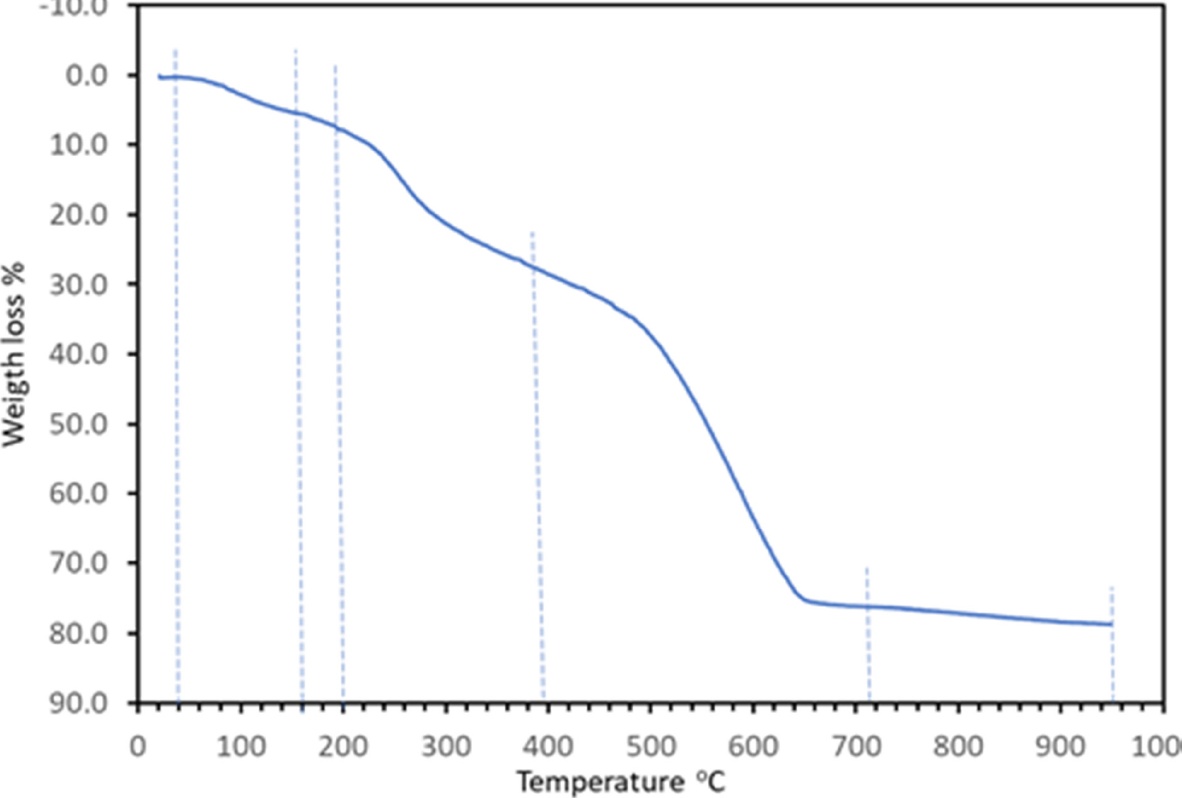
Figure 7. The electronic (diffuse reflectance) spectrum of compound 1 .